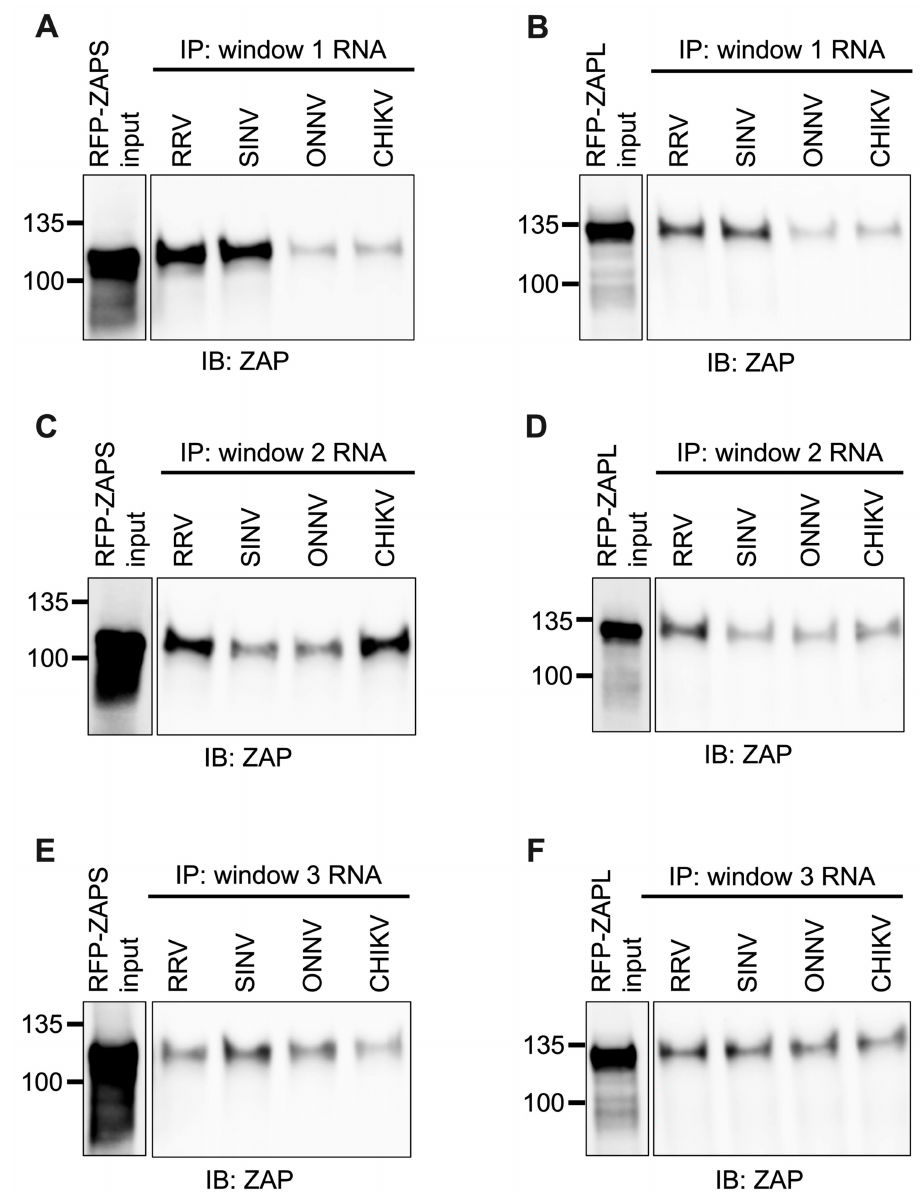
Figure 7. ZAPS and ZAPL binding to one but not all CpG-correlated windows correlates with alphavirus replication sensitivity to ZAP. Lysates of ZAP KO 293T cells with induced expression of RFP-ZAPS ( A , C , E ) or RFP-ZAPL ( B , D , F ) were incubated with biotinylated RRV, SINV, ONNV, or CHIKV CpG-correlated window 1 ( A , B ), window 2 ( C , D ), or window 3 ( E , F ) RNA. Follow- ing streptavidin-mediated pull-down of biotinylated RNA, ZAP associated with each RNA and in whole cell lysate (input) was assayed by immunoblot. Expected sizes: RFP-ZAPS = 106 kDa, RFP-ZAPL = 130 kDa. Data are representative of results from three independent experiments for window 1 and two independent experiments for windows 2 and